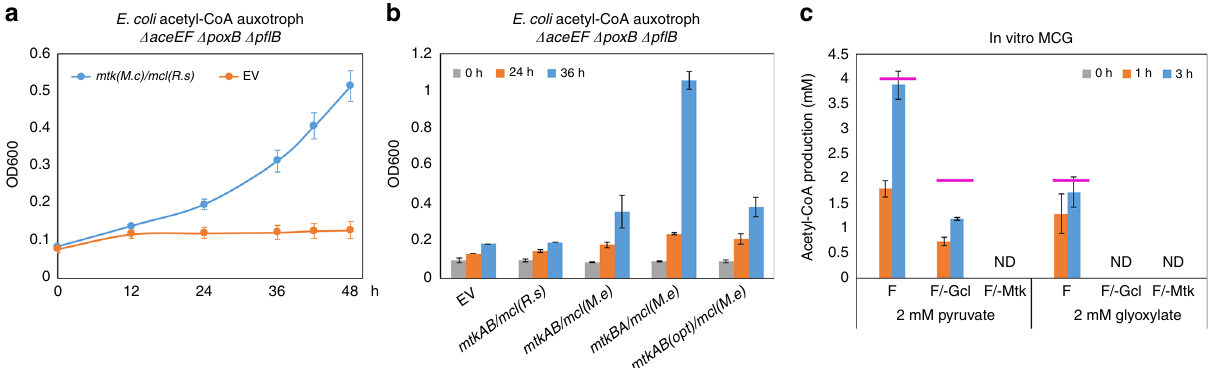
Fig. 2 Rescue of an acetyl-CoA auxotroph and demonstration of the MCG pathway in vitro. a Expression of mtk ( M.c ) /mcl ( R.s ) could rescue the growth defect of the acetyl-CoA auxotroph ( Δ aceEF Δ poxB Δ p fl B ) and allowed the strain to grow in minimal medium with 1% glucose addition within 48 h. EV, empty vector. b Expression of the genes in the order of mtkB ( M.c ) /mtkA ( M.c ) /mcl ( M.e ) improved the growth of the Δ aceEF Δ poxB Δ p fl B strain to the highest culture density in minimal medium with glucose as the sole carbon source in 36 h. Opt, codon optimization. c Measurement of acetyl-CoA production through the in vitro MCG pathway. Two millimolar pyruvate (or glyoxylate) was used as the initial substrate to evaluate the effect of the pathway. F, full enzyme mixture; F/-Gcl, full enzyme mixture omitting Gcl; F/-Mtk, full enzyme mixture without Mtk addition; ND, not detectable. Magenta lines indicated the theoretical titer of the MCG pathway by using 2 mM pyruvate (or glyoxylate) as the initial substrate. Error bars are s.d. (standard deviation), n =